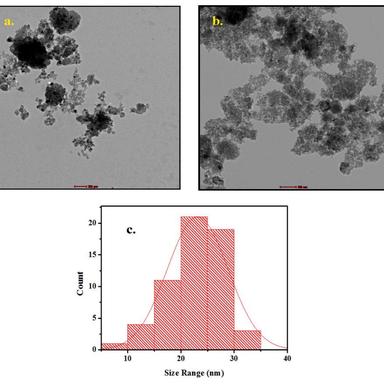
(a,b) TEM images of MnFe2O4/OV at different resolution (c) Size distribution histogram of MnFe2O4/OV.